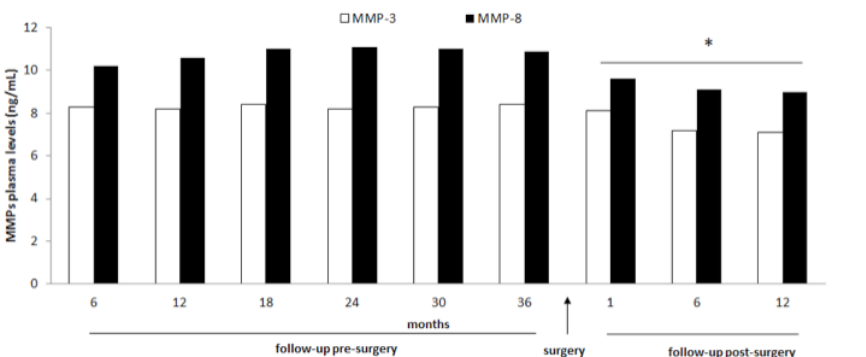
Figure 3: Plasma levels of MMP-3 and MMP-8, measured through ELISA test in patients during the follow-up before and after the surgery. *P<0.01 post-surgery vs